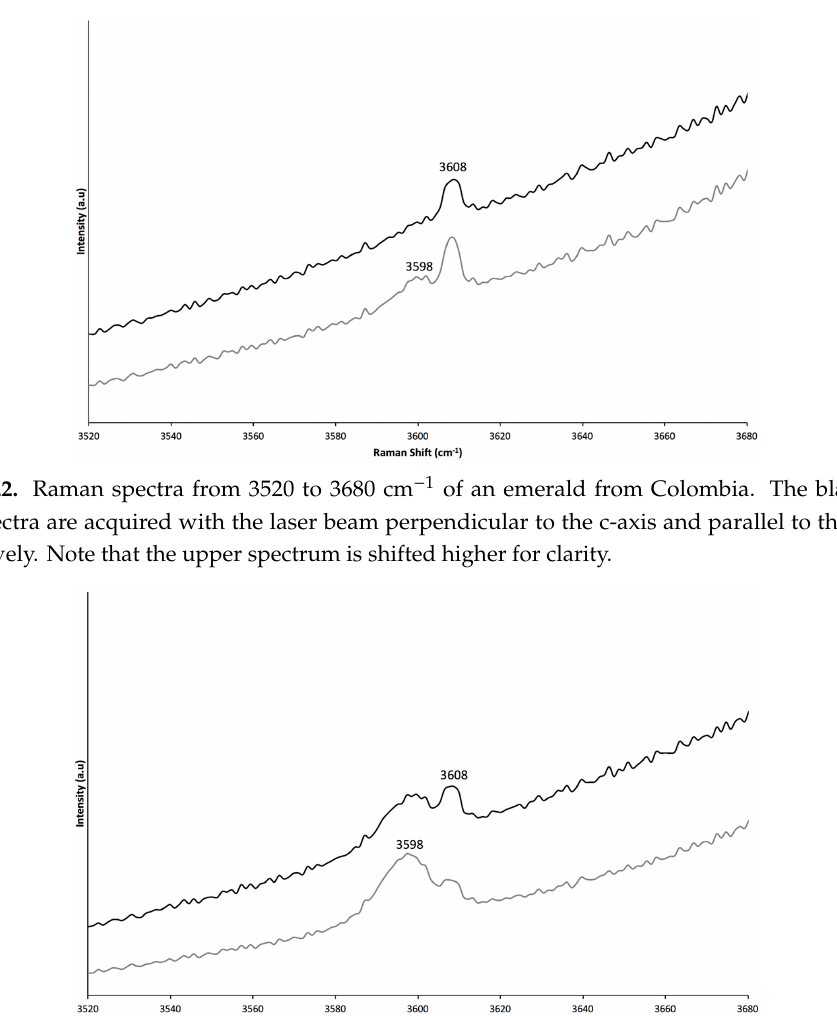
Figure 21. Raman spectra from 200 to 1300 cm − 1 of an emerald from Colombia. The black and grey spectra are acquired with the laser beam perpendicular to the c ‐ axis and parallel to the c ‐ axis, respectively. The upper spectrum has been vertically offset for clarity.